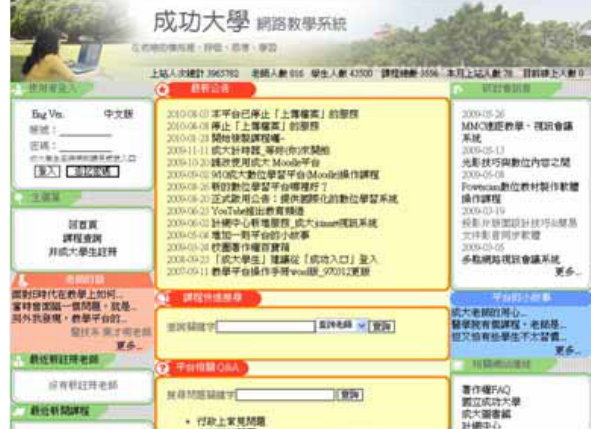
Figure 1. Front page of the ITeach network teaching system in NCKU ( website: http://iteach.ncku.edu.tw/ ) Configurations